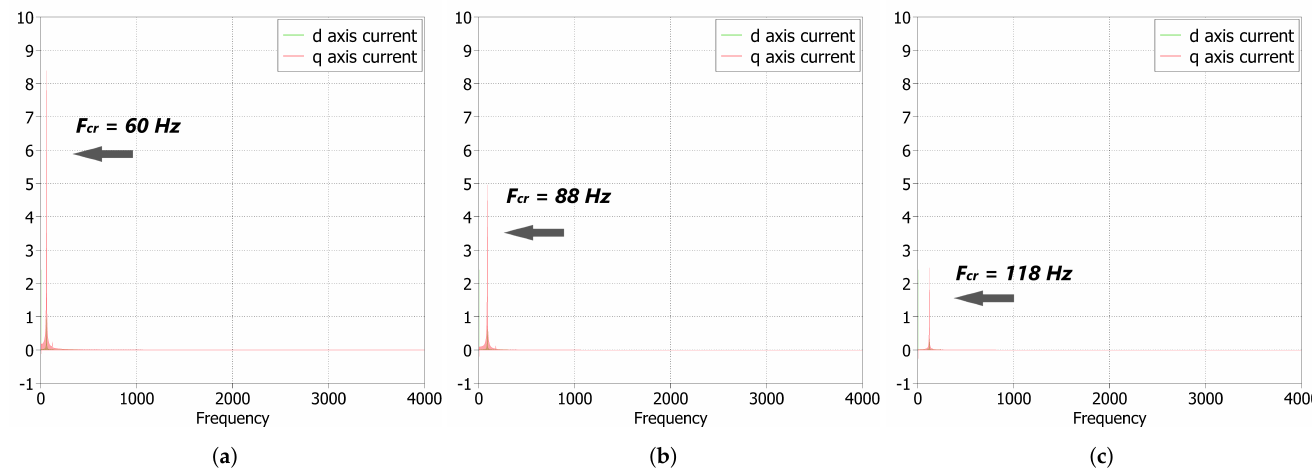
Figure 18. FFT analysis of the VSC inductor current I L for different AVC filter cases in the weak grid (SCR = 1.5). The dominant oscillation frequency is shown when K I , a obtains its critical